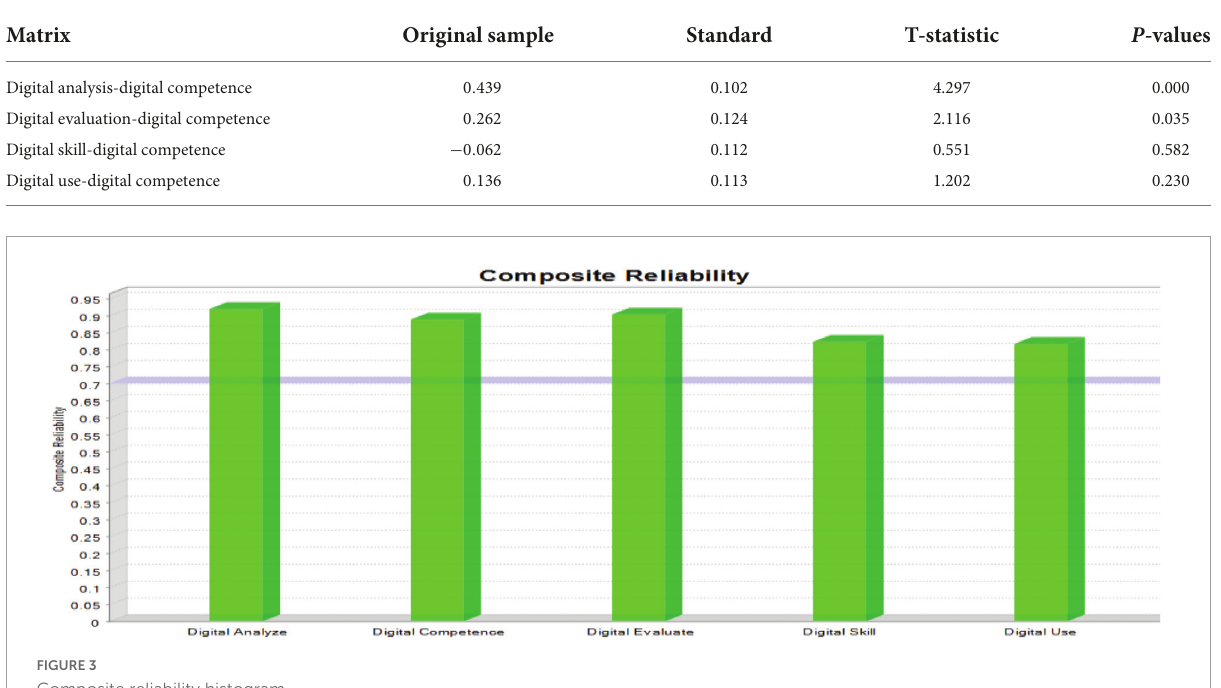
FIGURE3 Composite reliability